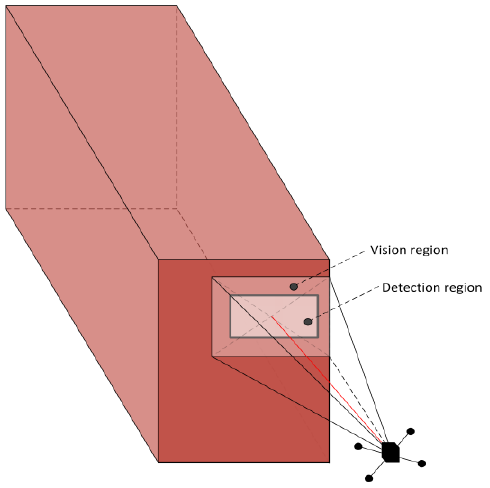
Figure 8. Schematic diagram of UAV detection region.